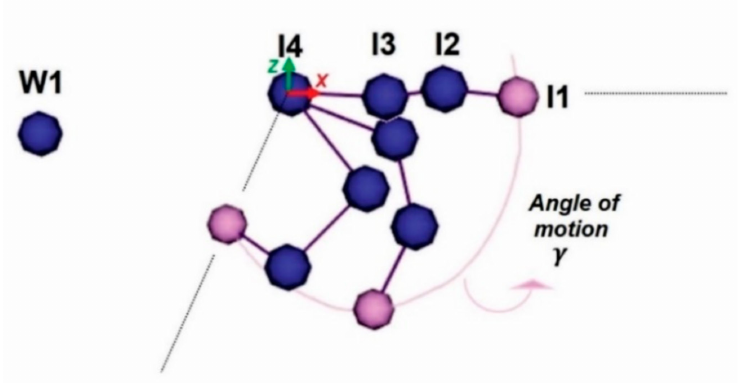
Figure 10. Finger trajectory in the xz plane.